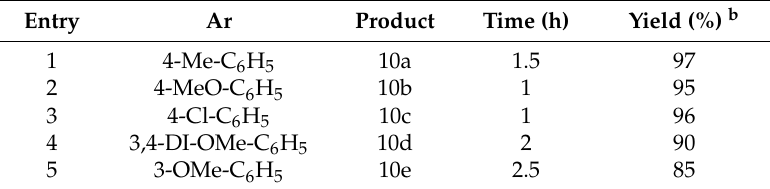
Table 4. Synthesis of bis-coumarin derivatives 10a–10e a using HUC